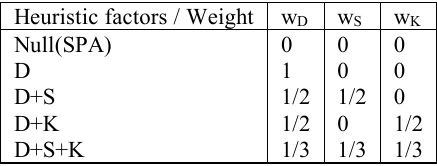
Table 1. Choice and weight configuration of heuristic factors